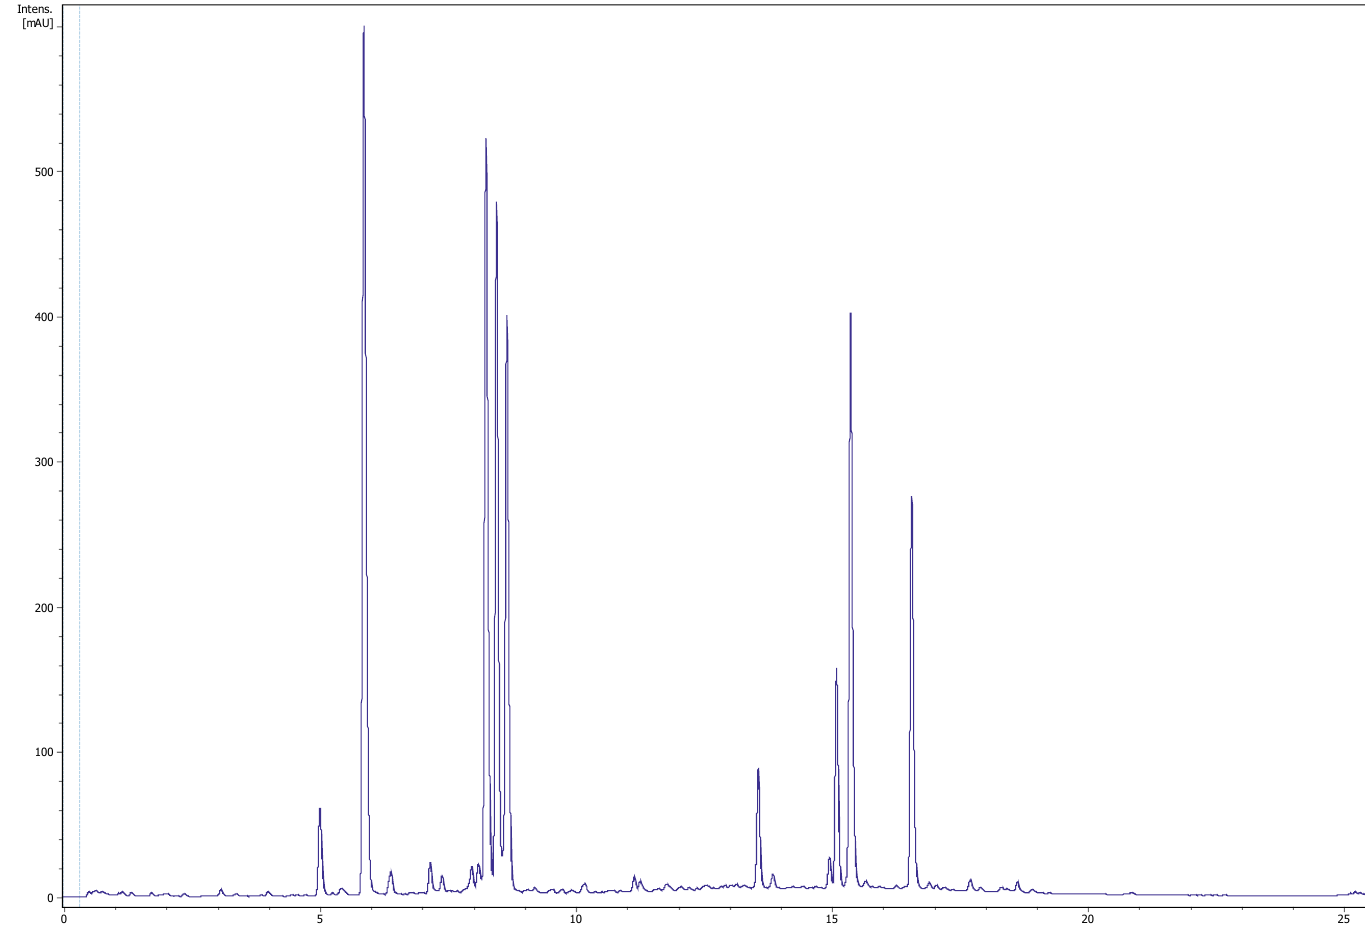
Figure A1. Ilex paraguariensis A.St.-Hil. leaves water extract, UV chromatogram, 280 nm.